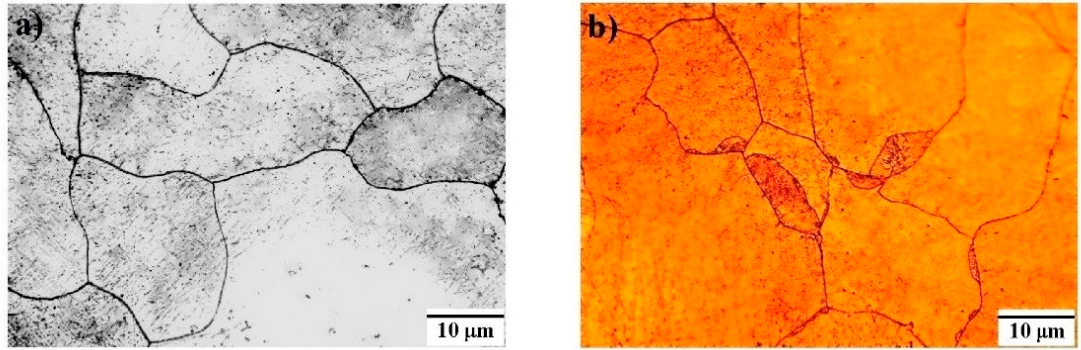
Figure 5. Optical micrographs of AZ91 alloy aged at 100 °C for ( a ) 4 h and ( b ) 192 h.